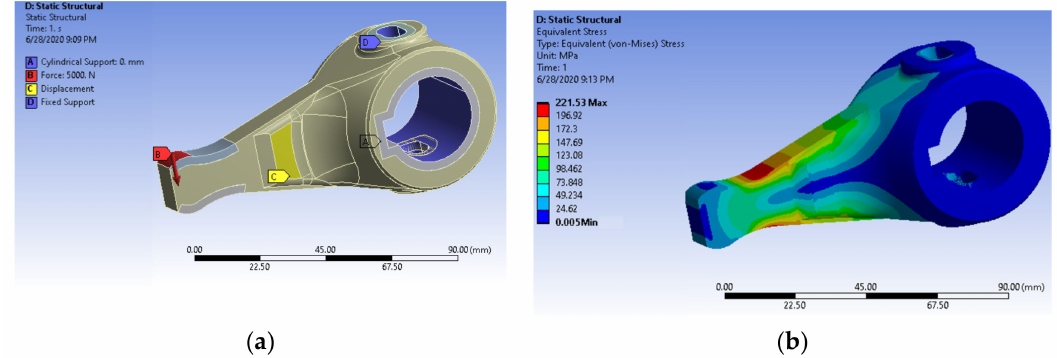
Figure 4. Boundary conditions applied to the model of the main shifting thumb ( a ) and resulting contours of von Mises stress ( b